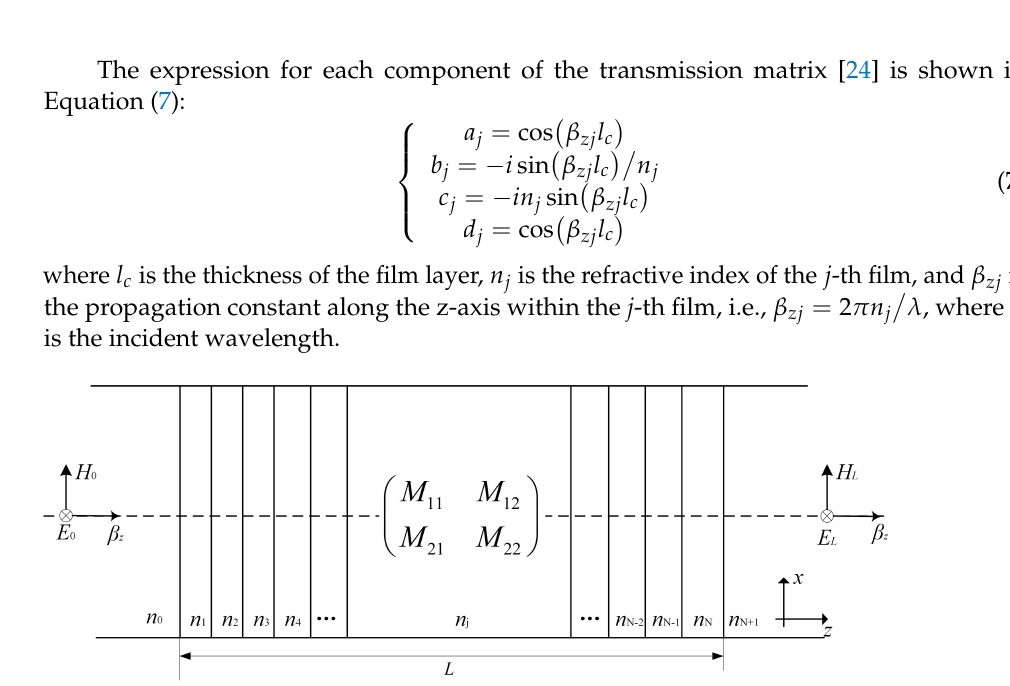
Figure 3. Schematic diagram of the multilayer film transfer